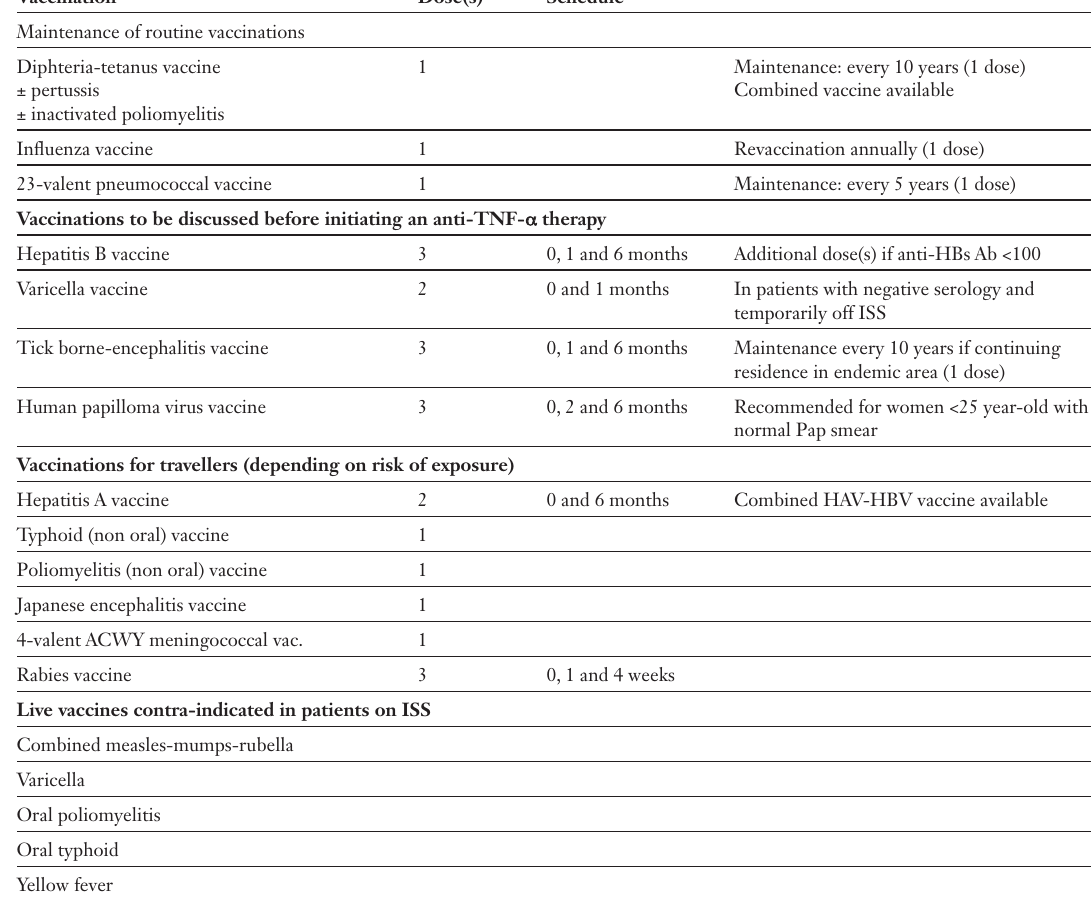
Table 3 Recommendations for